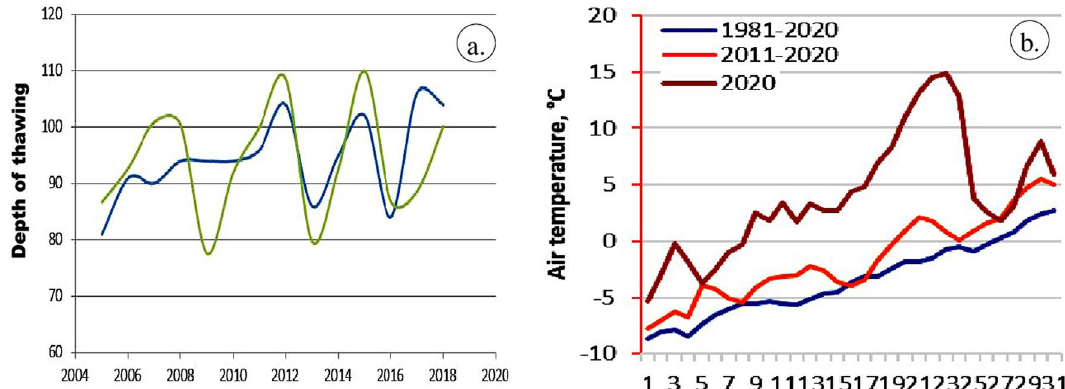
Figure 10. ( a ) Comparison of the calculated (green) and observed (blue) variations in the depth of seasonal thawing in Talnakh in the 2005–2019 period, ( b ) Mean daily air temperatures in May in Norilsk averaged